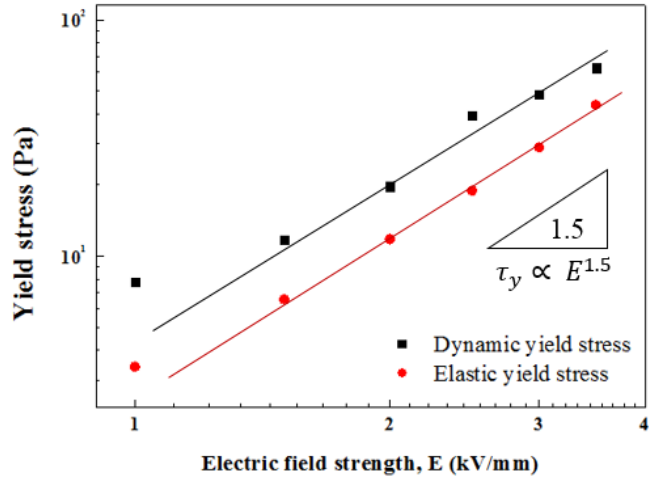
Figure 11. Yield stress as a function of E of ZnFe 2 O 4 /PMA-based ER fluid.